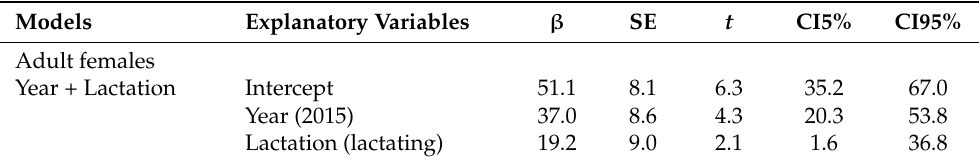
Table 5. Explanatory variables (category), estimates ( β ), standard errors (SE), t -values ( t ) and confidence intervals (CI5% and CI95%) of the best models assessing the effects of age, lactation status and year on the diversity of mushrooms consumed by adult female white-tailed deer on Anticosti Island (Qu é bec, Canada). Intercept categories are non-lactating and